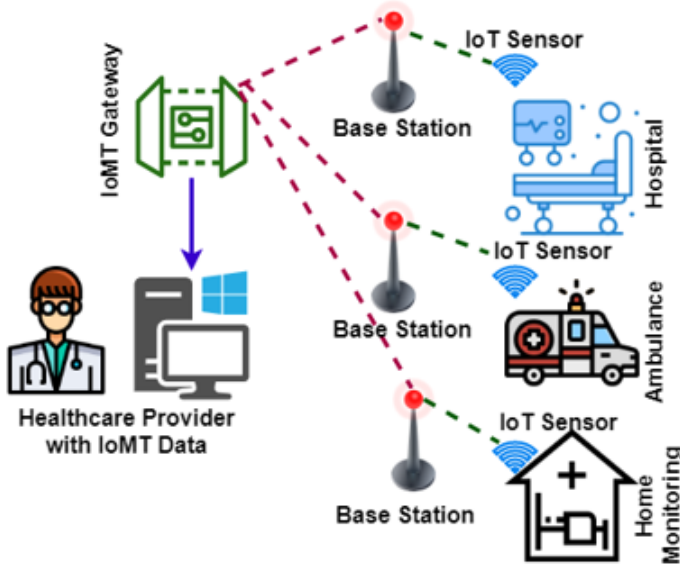
Figure 2. Overview of IoMT architecture. The figure shows the overall concept of the IoMT-based data acquisition, storage, processing, and distribution system. Base stations accumulate data from disparate sensors deployed in diverse situations. Data from the base station are received by the healthcare providers through the